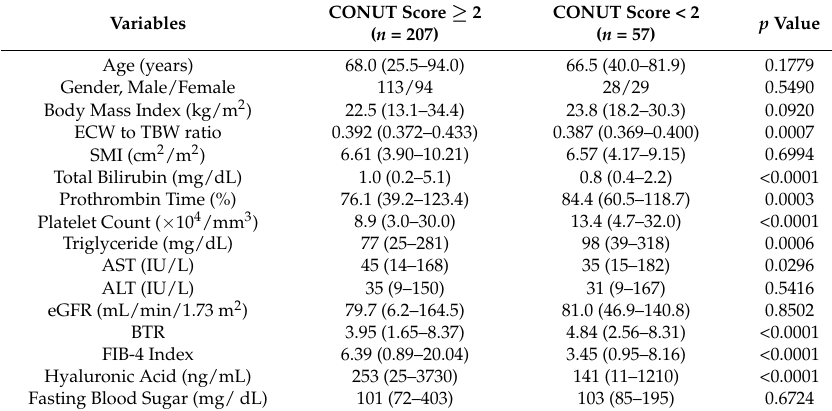
Table 4. Comparison of baseline characteristics between CONUT score ≥ 2 and CONUT score < 2.